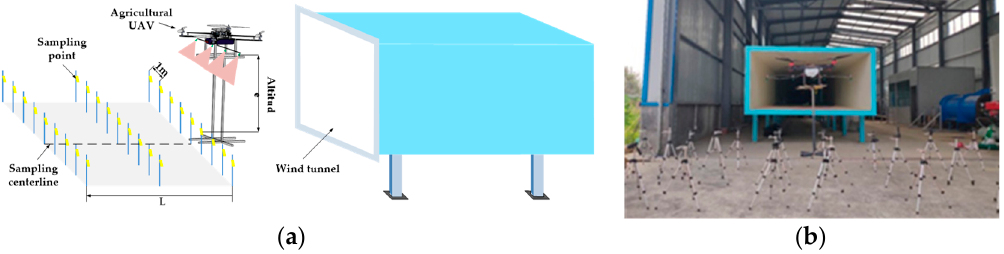
Figure 3. Schematic diagram of sample data collection experiment: ( a ) Sketch map of sample data collection; ( b ) Sample Data Acquisition Site; Note: L is the length of the sampling area.